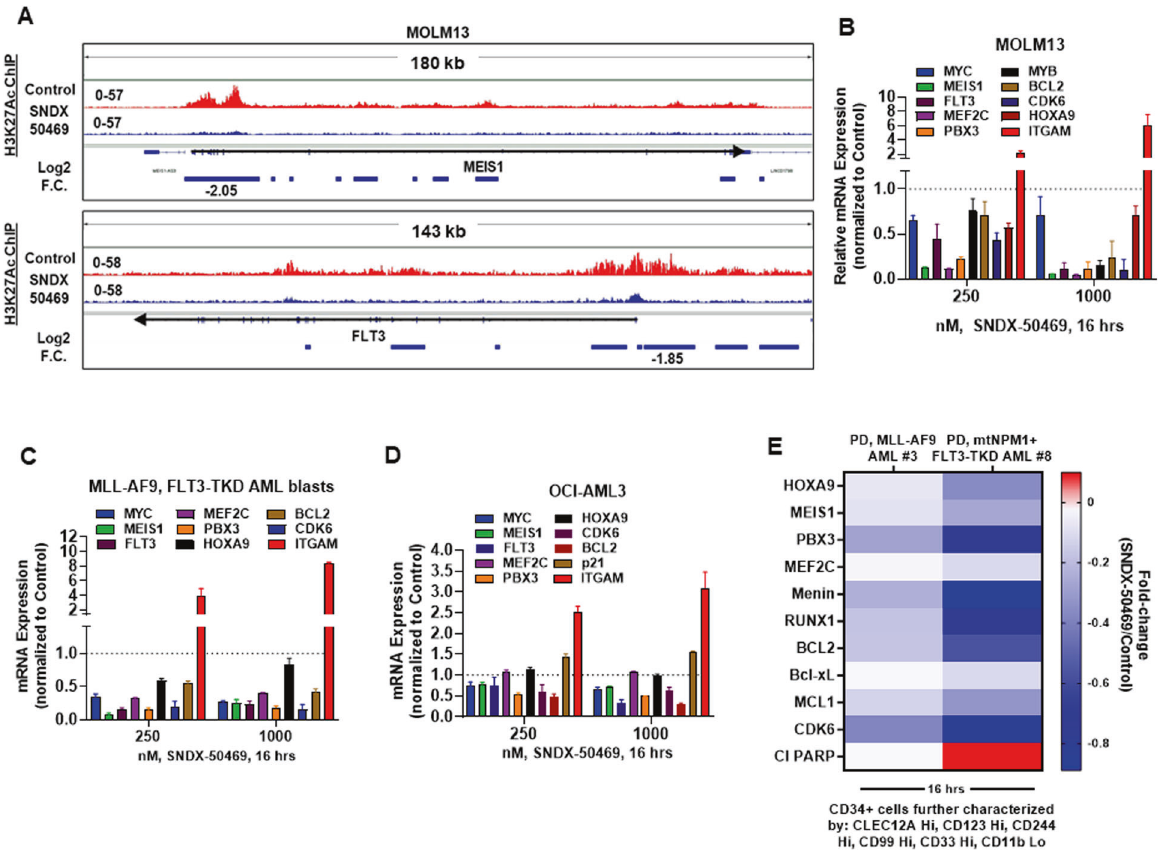
Fig. 3 Menin inhibitor treatment depletes H3K27 acetyl mark on chromatin, depletes mRNA expression of MYC, MEIS1, and FLT3 in cultured and primary AML blasts and depletes Menin, BCL2, and MLL target gene expression levels in phenotypically de fi ned